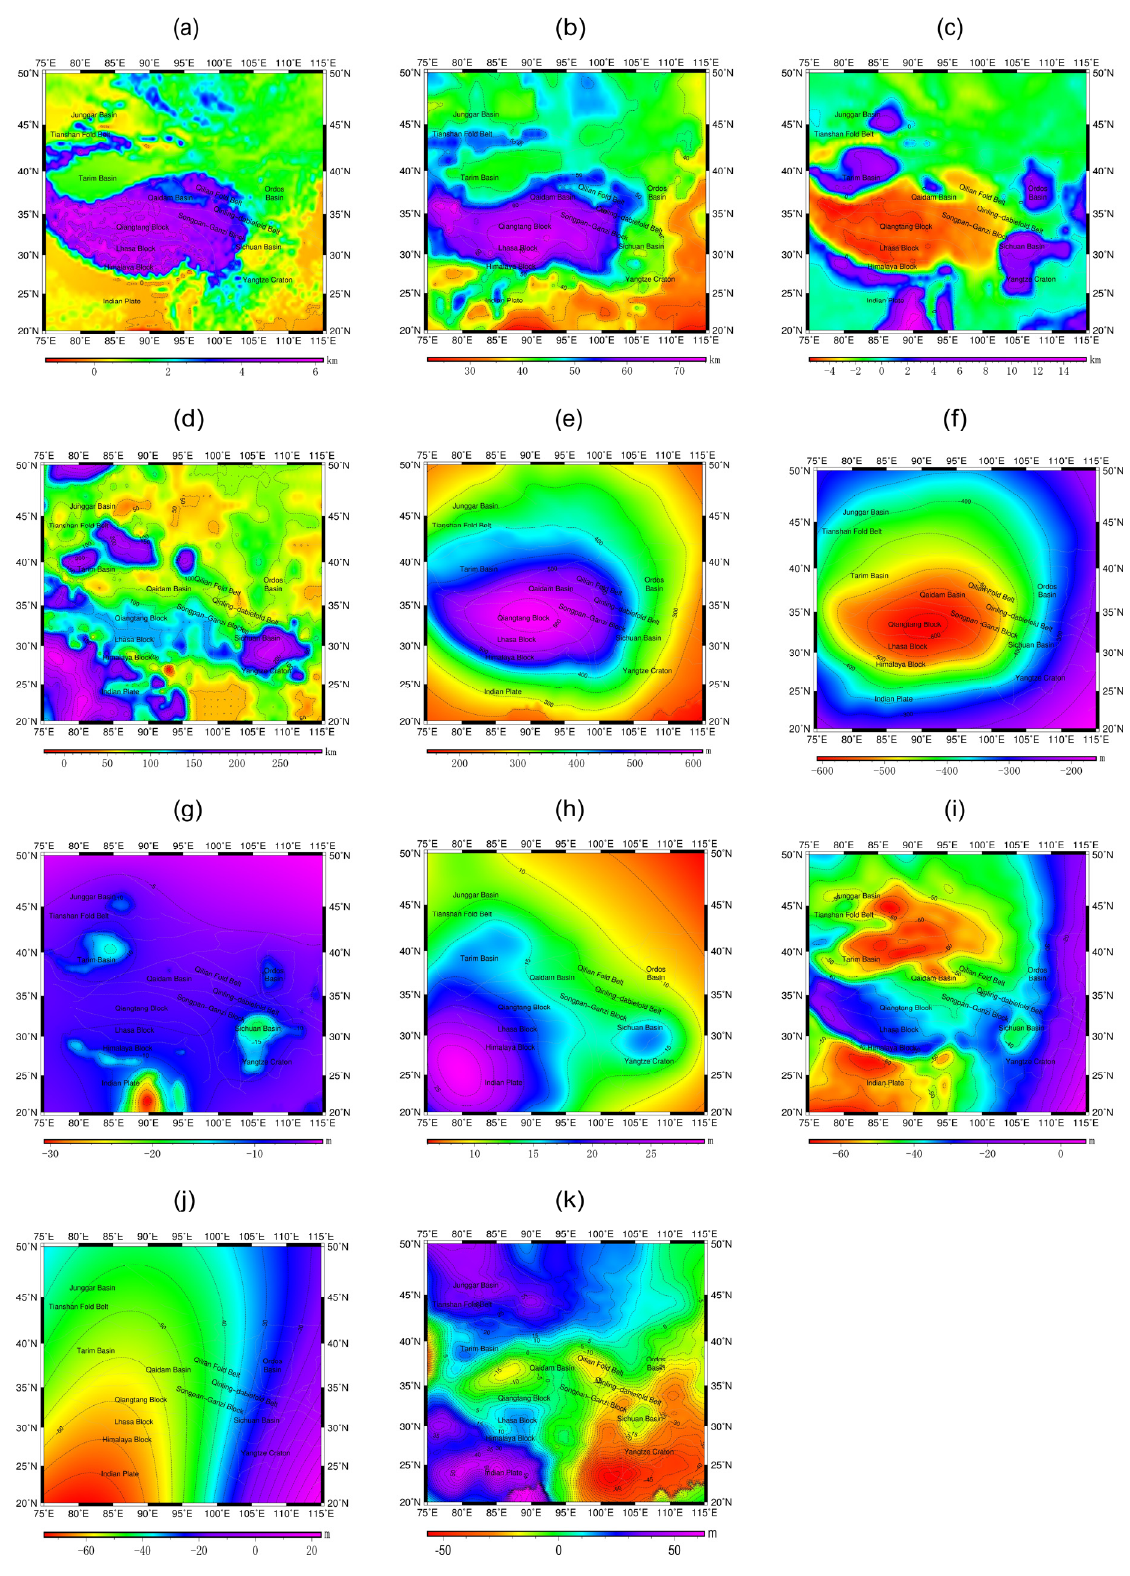
Figure 2. ( a ) Topography of the TP; ( b ) Moho depth of the TP; ( c ) sedimentary depth of the TP; ( d ) lithospheric depth of the TP; ( e ) effect of topographic masses; ( f ) effect of variations in the Moho interface; ( g ) effect of variations in the sedimentary interface; ( h ) effect of variations in the lithospheric interface; ( i ) geoid anomaly from EGM2008 to degree 180; ( j ) geoid anomalies from EGM2008 of degree 2–6; and ( k ) residual geoid anomaly after the above-motioned contributions are reduced.